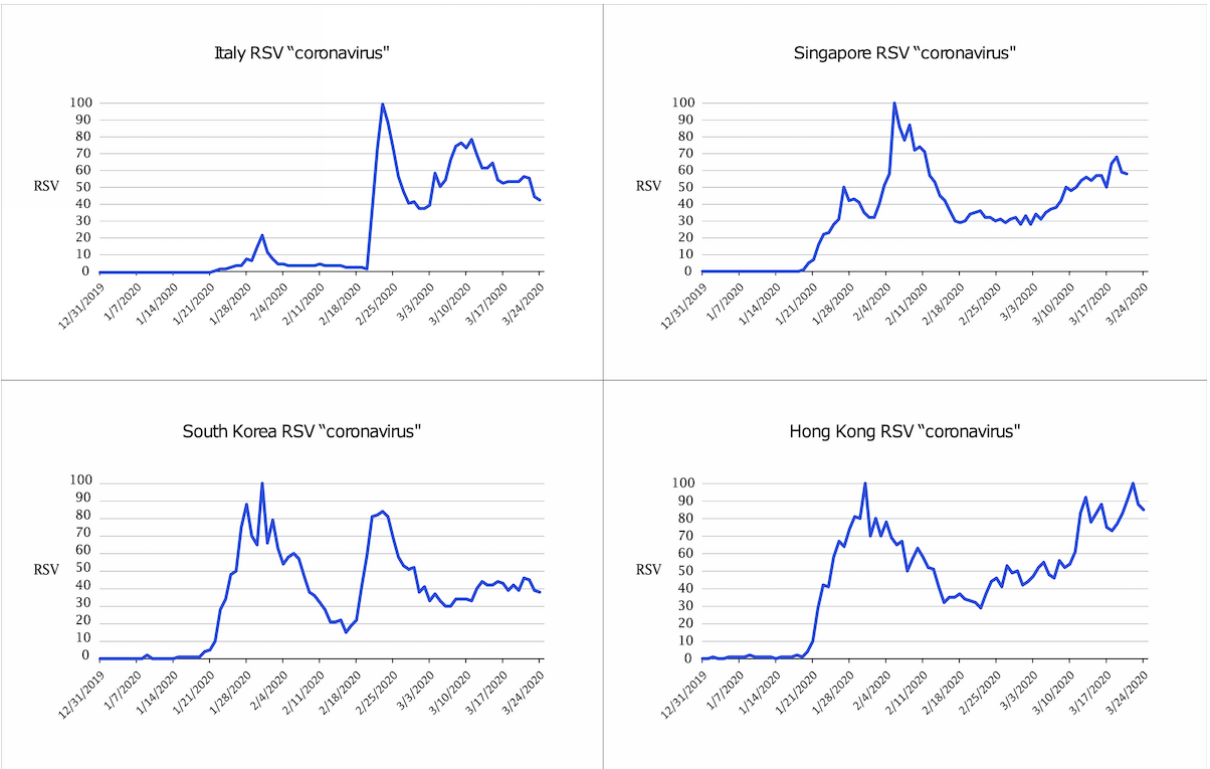
Figure 3. Graphs of Google Trends RSVs (0-100) for the keyword coronavirus vs time from December 31, 2019 to March 24, 2020 in Italy, Singapore, South Korea, and Hong Kong. RSV: relative search